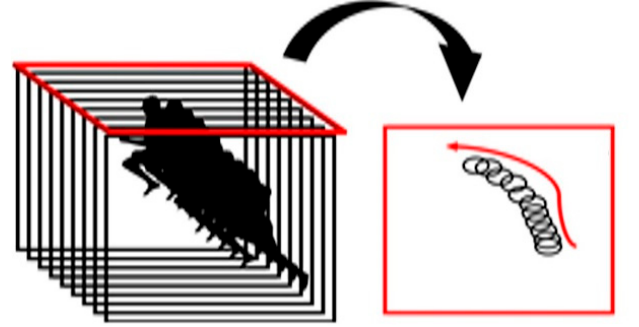
Figure 3. Dimension reduction in Y-Z axis.